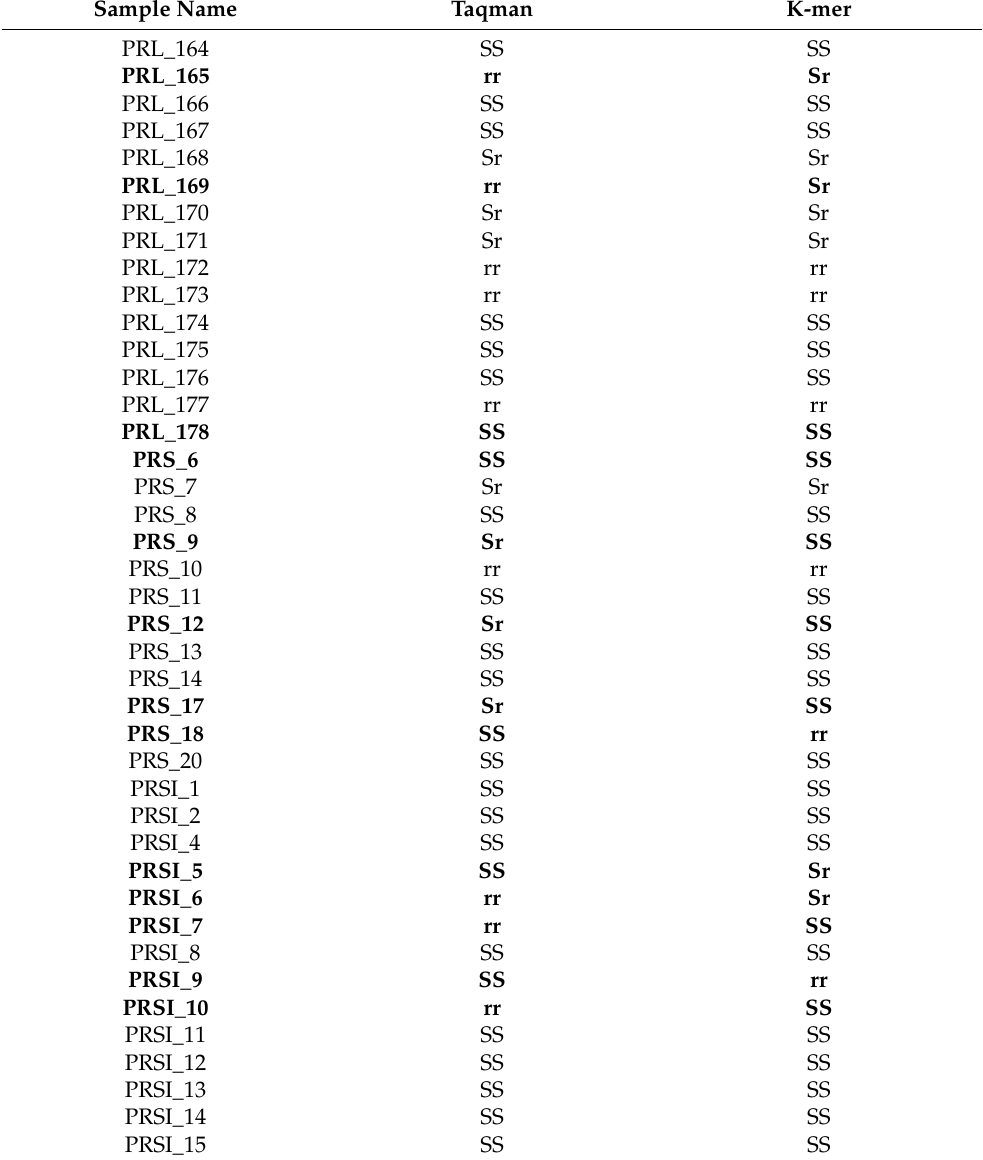
Table 1. Concordance between results using Taqman and k-mer-based genotyping for the SfABCC2mut (GC insertion) allele, represented as the “r” allele. Samples with discrepant geno- types are highlighted in bold